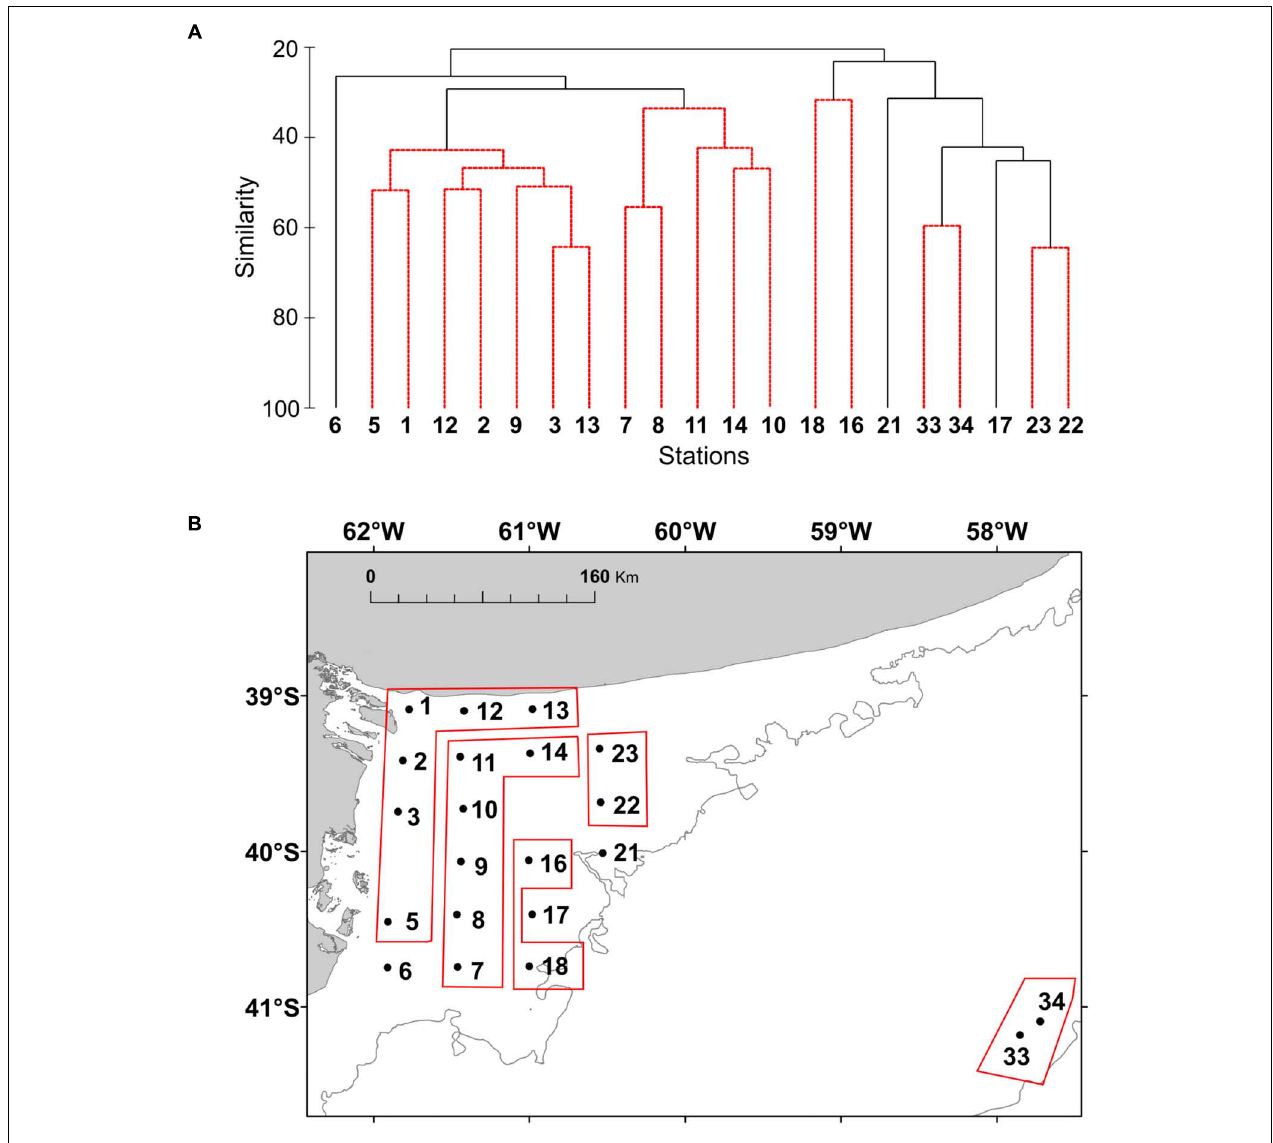
FIGURE 7 | (A) Cluster analysis based on Bray-Curtis similarity index of the plankton community at the study stations of El Rincón in September 2015.The abundance of the species (cells L − 1 ) was transformed using log (x + 1). (B) The resulted groups from the SIMPROF are shown in the map of the study